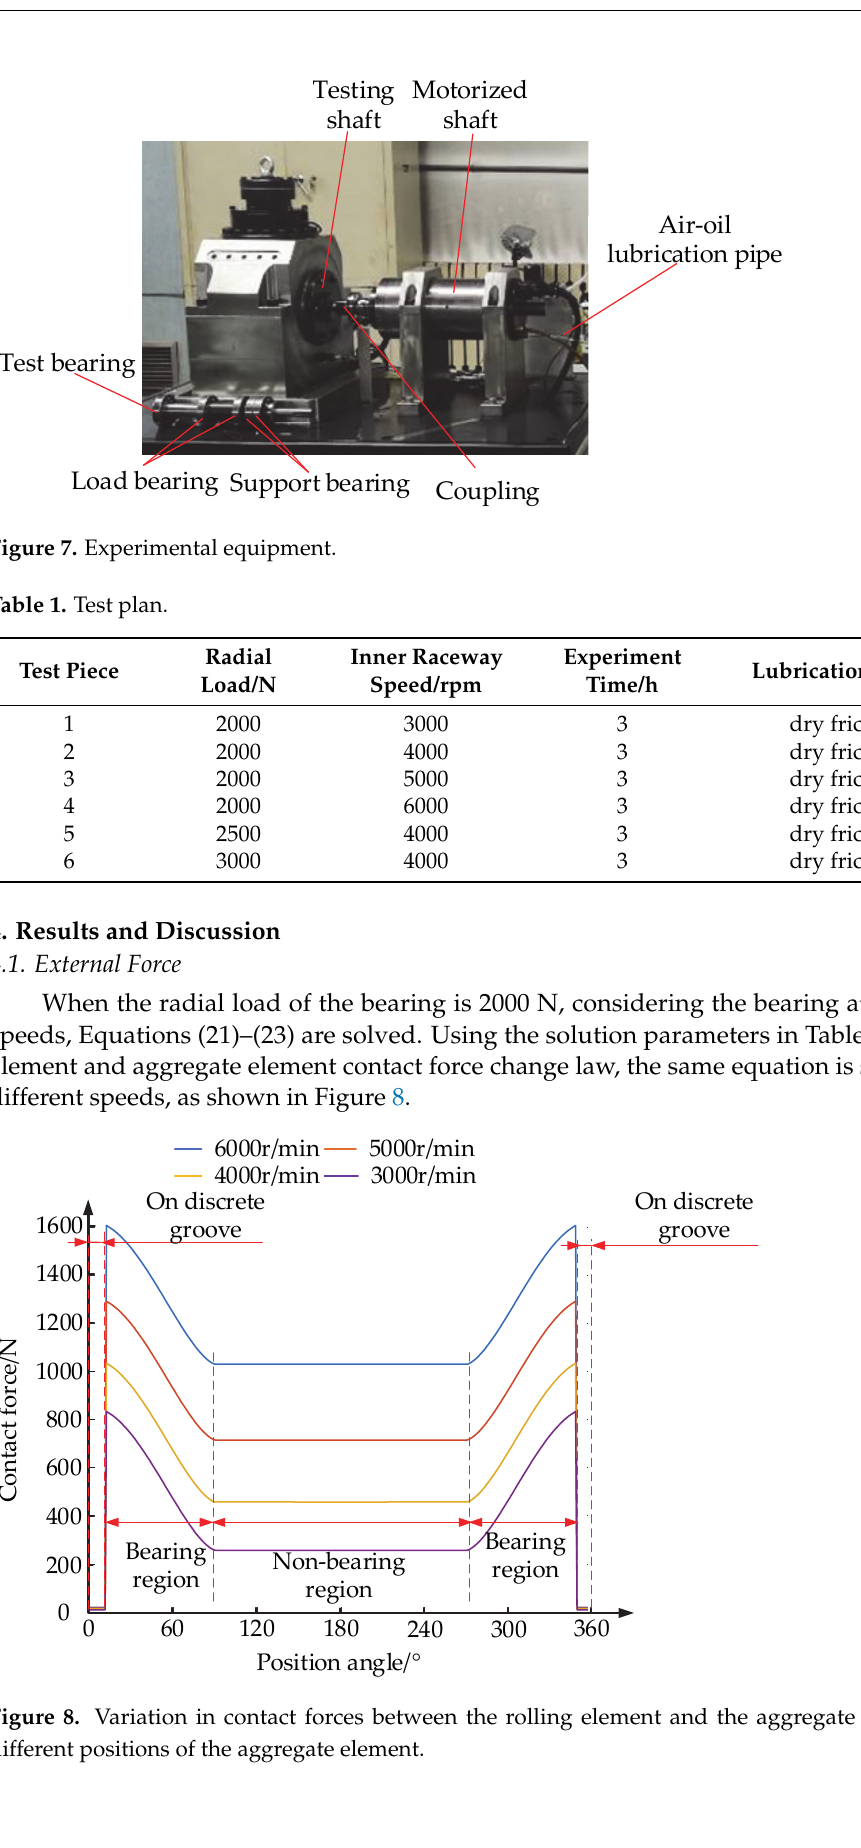
Figure 8. Variation in contact forces between the rolling element and the aggregate element at dif- ferent positions of the aggregate element. different positions of the aggregate